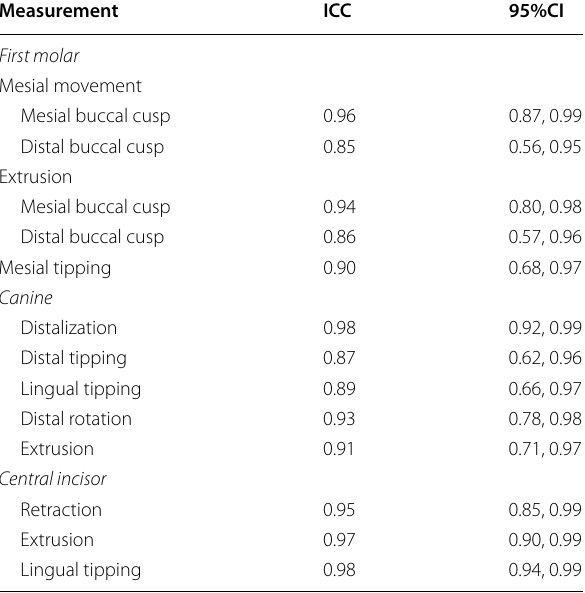
Table 2 Intra-class correlation coefficient of tooth measurement